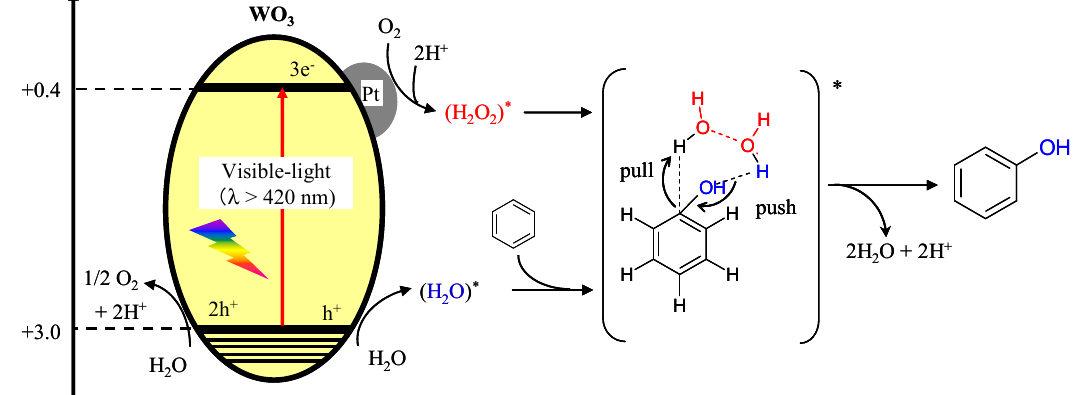
Figure 6. Reaction mechanisms for the hydroxylation of benzene into phenol in the presence of O 2 and H 2 O on the Pt-WO 3 under visible light irradiation. (*) indicates formation of activated H 2 O and H 2 O 2 intermediates by photo-excitation.